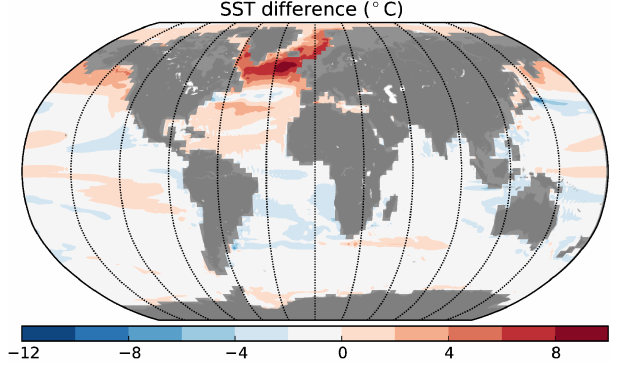
Figure 7. Sea surface temperature difference between simulations 11 and 15 (see Table 1). There is a clear warming pattern in the North Atlantic, which affects the mean sea-surface